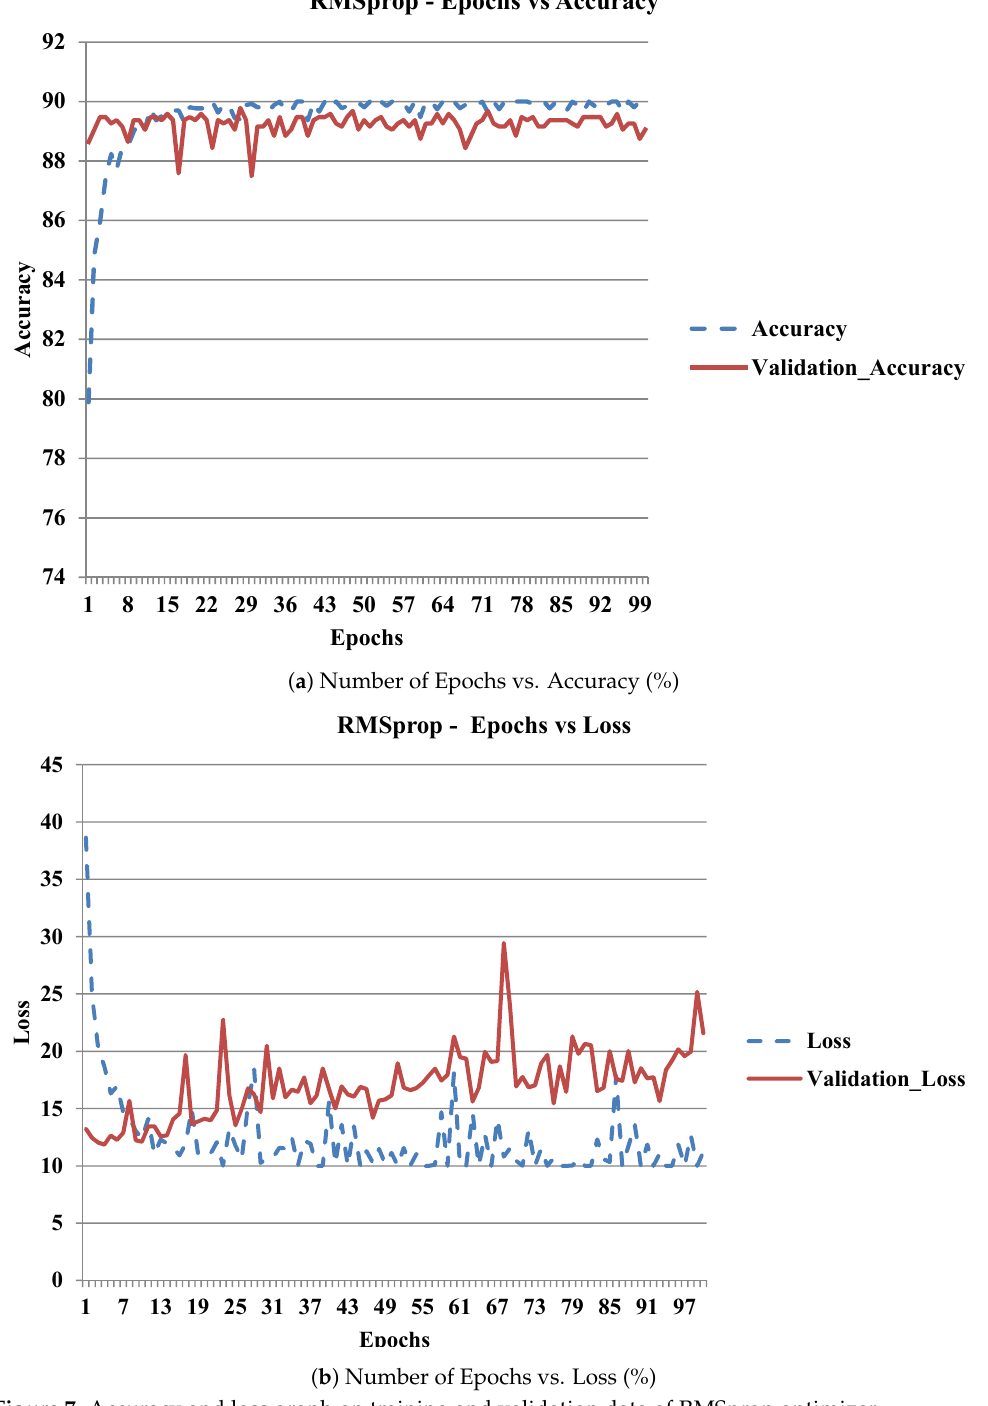
Figure 7. Accuracy and loss graph on training and validation data of RMSprop